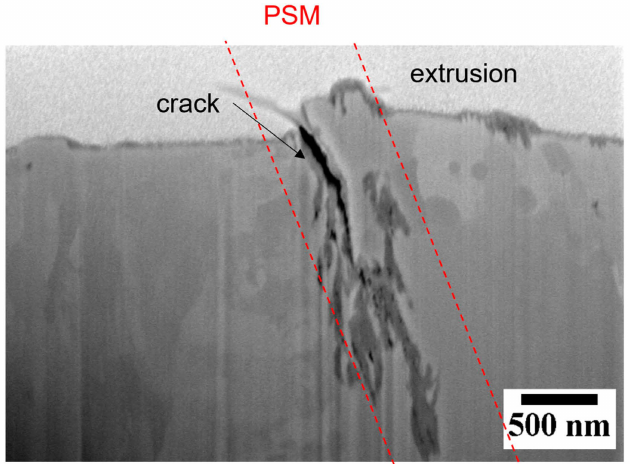
Figure 12. FIBsectionthroughapersistentslipmarking(PSM)atthesurfaceofthe50CrMo4—37HRCsteel, tested at 95 Hz, σ a = 480 MPa, run out after 2 × 10 8 cycles, showing crack initiation and void